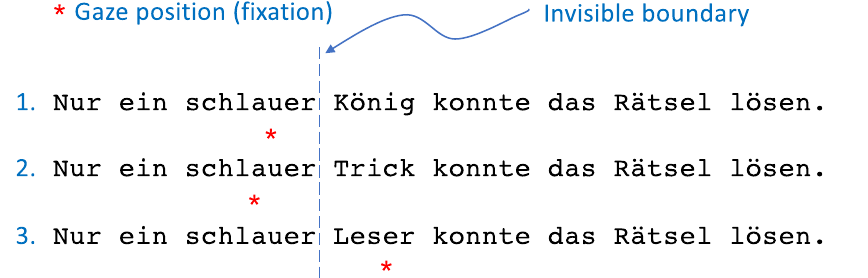
Figure 1. The boundary technique as a variant of gaze-contingent displays. The critical word position is to the right of an invisible boundary. If gaze position is to the left of the boundary ( first line ), the preview word is diplayed. The preview is either a high-frequency word ( König ) or a low-frequency word ( Trick ). A saccade crossing the boundary triggers an immediate display change that replaces the preview by a medium-frequency word ( Leser